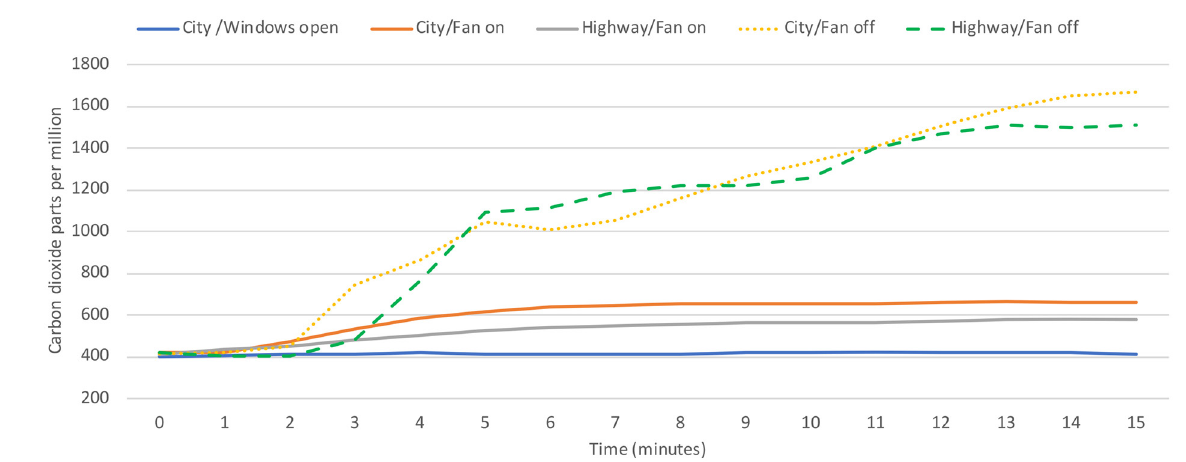
Figure 3. Carbon dioxide levels in motor vehicles driven under differing ventilation conditions. The 5 cars had 2 occupants and the van had 3 occupants. Windows were closed unless otherwise specified. Windows open indicates that 1 front window was partially or fully open. Carbon dioxide readings above 800 parts per million were considered an indicator of suboptimal